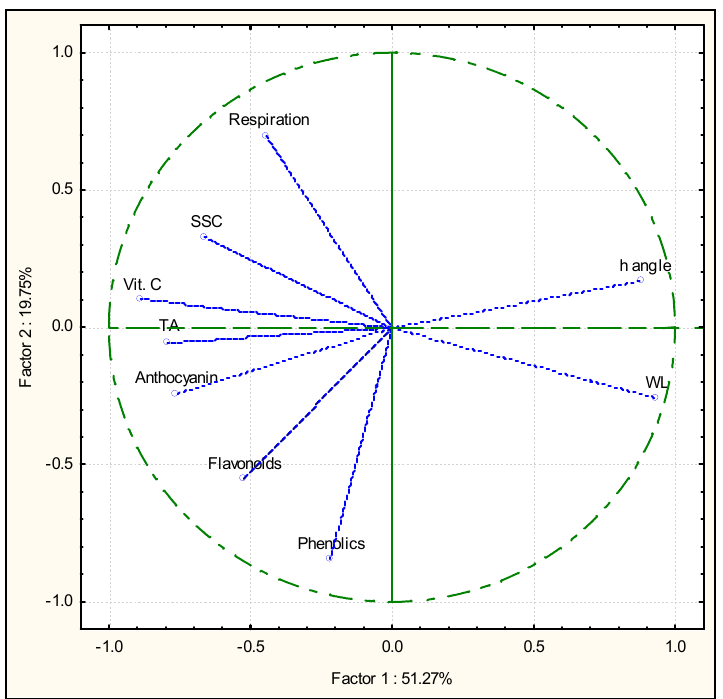
Figure 7. Principal component analysis (PCA) of tested parameters of pomegranate arils.